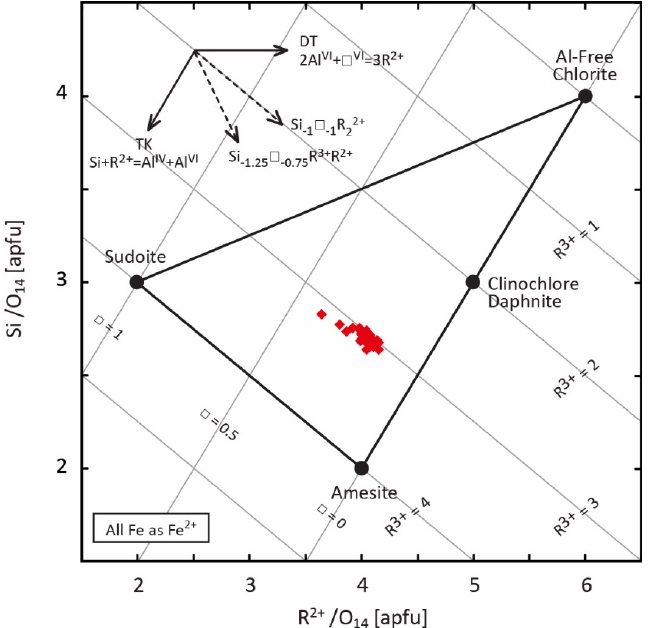
Figure 11. Chlorite chemical compositions (chlorite of the veins/shale interface) in R 2+ –Si diagram [34]. R 3+ refers to trivalent cations (Al and Fe 3+ ), to octahedral vacancies and R 2+ to divalent cations (Fe 2+ and Mg). TK and DT refer to the Tschermak (Si + R 2+ = IV Al + VI Al) and the di-trioctahedral (2 VI Al + VI = 3 R 2+ ) exchanges, respectively.